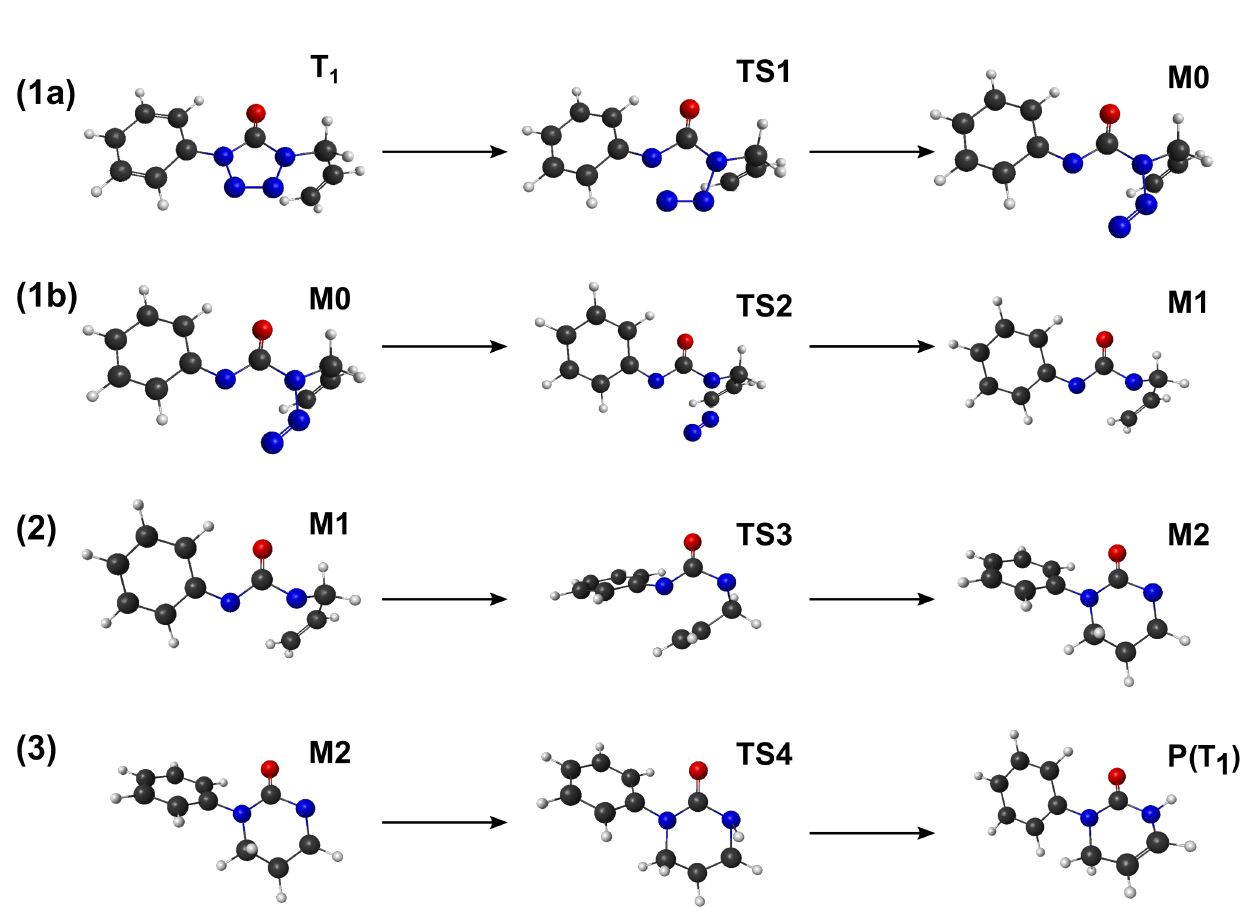
Figure 5. Structures along the pathway from T 1 towards